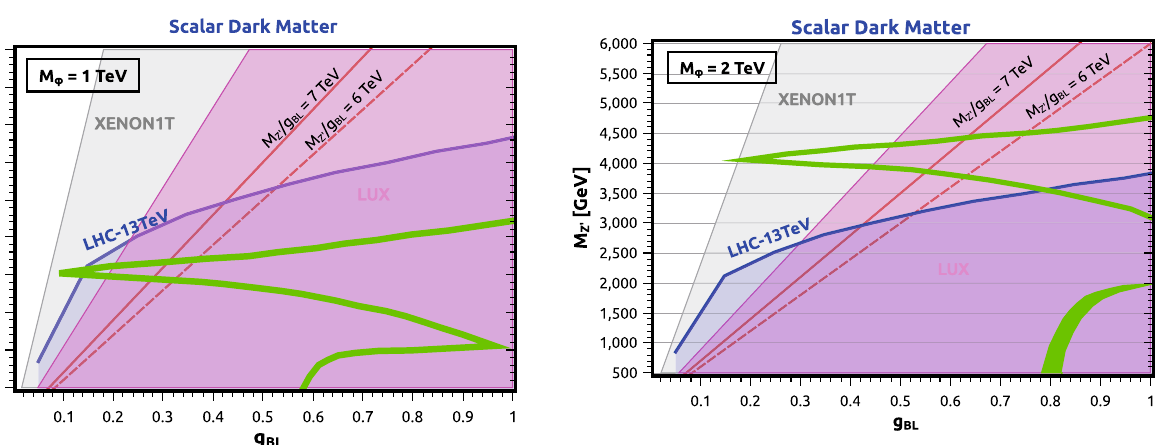
Fig. 12 Allowed region of parameters for a 1 TeV scalar field as dark matter. The green curve delimits the region of parameter space with the right abundance ( (cid:2) h 2 = 0 . 11 − 0 . 12), the pink ( gray ) shaded region is ruled out by LUX2016 (XENON1T), the blue region is excluded by dilepton data from the LHC, and the solid red ( dashed ) lines rep- resent the current (old) LEP-II bounds, namely M Z (cid:2) / g BL > 7 TeV ( M Z (cid:2) / g BL > 6 TeV)